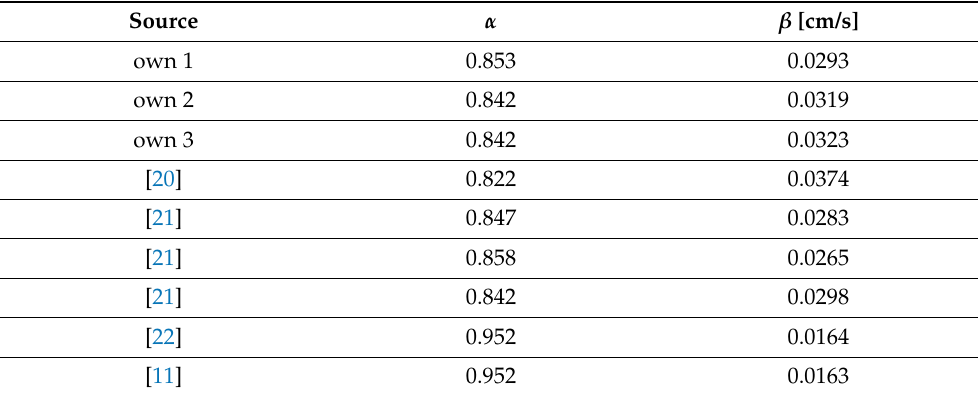
Table 2. The values of the exponent α and the coefficient β for JA-2